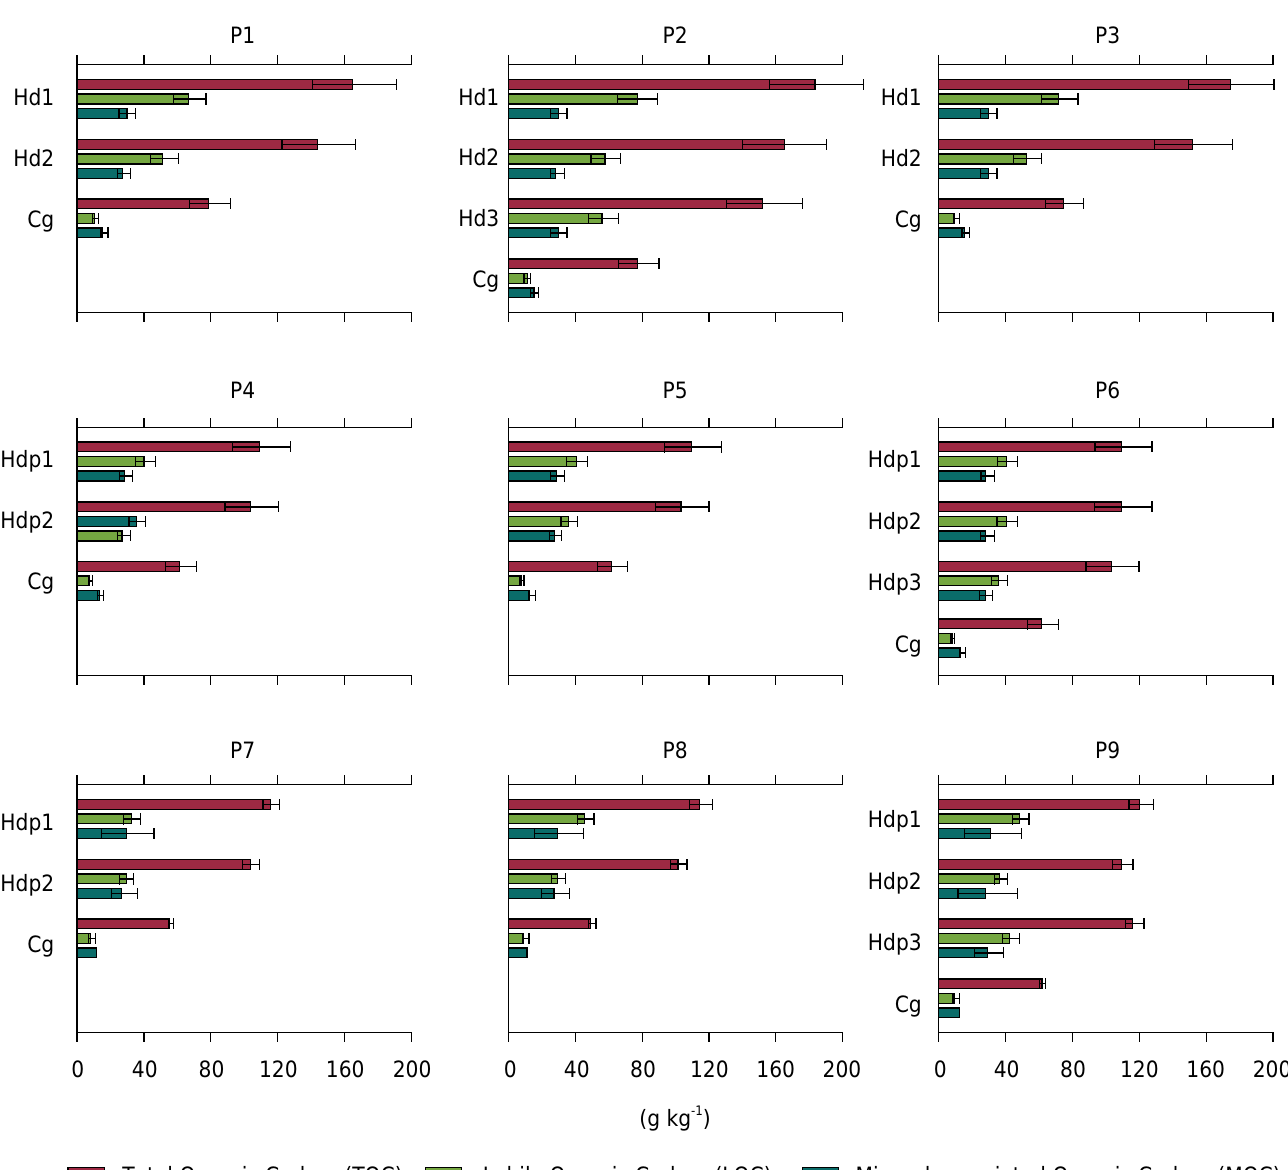
Figure 5. Total organic carbon and organic carbon fractions of the studied Histosol profiles. P1, P2, and P3: Area 1 - secondary tropical forest (natural vegetation); P4, P5, and P6: Area 2 - Conventional tillage of cassava ( Manihot esculenta ); P7, P8, and P9: Area 3 - intercropped coconut ( Cocos nucifera ) with cassava ( Manihot esculenta